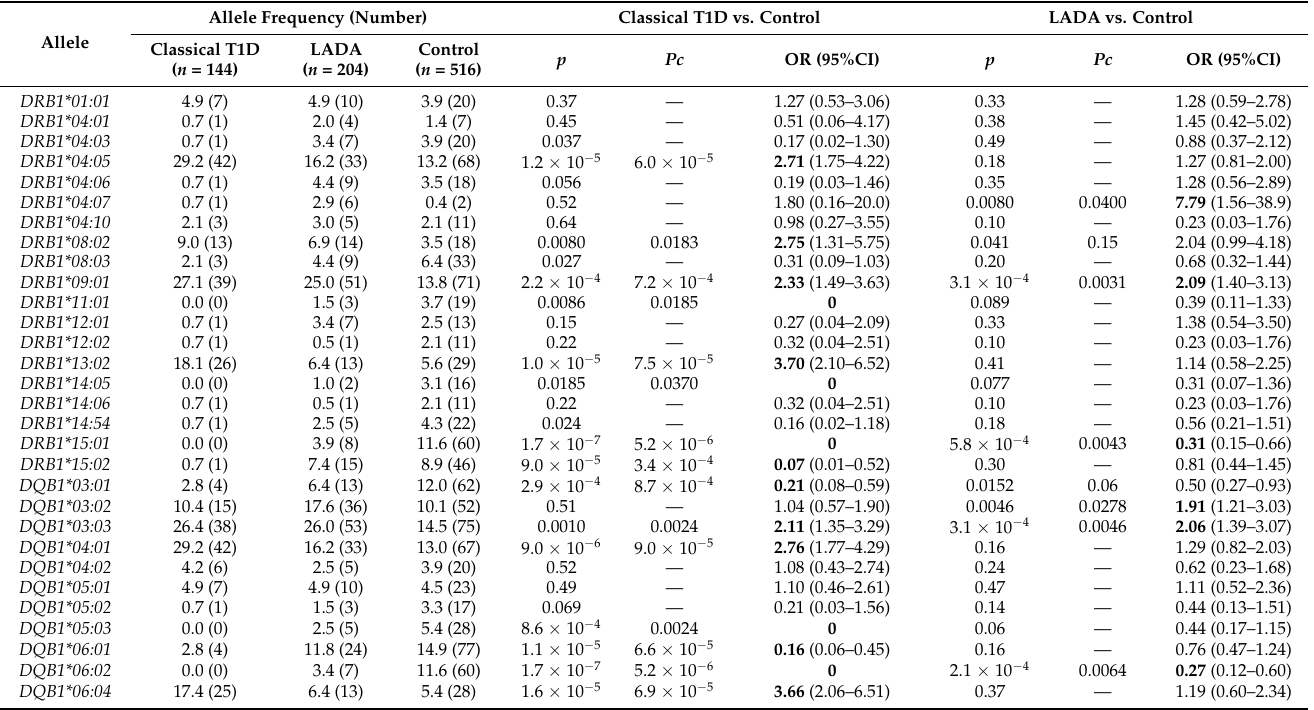
Table 1. HLA-DRB1 and -DRB1 allele frequencies in patients with classical T1D, patients with LADA, and in controls. Allele Frequency (Number) Classical T1D vs. Control LADA vs. Allele